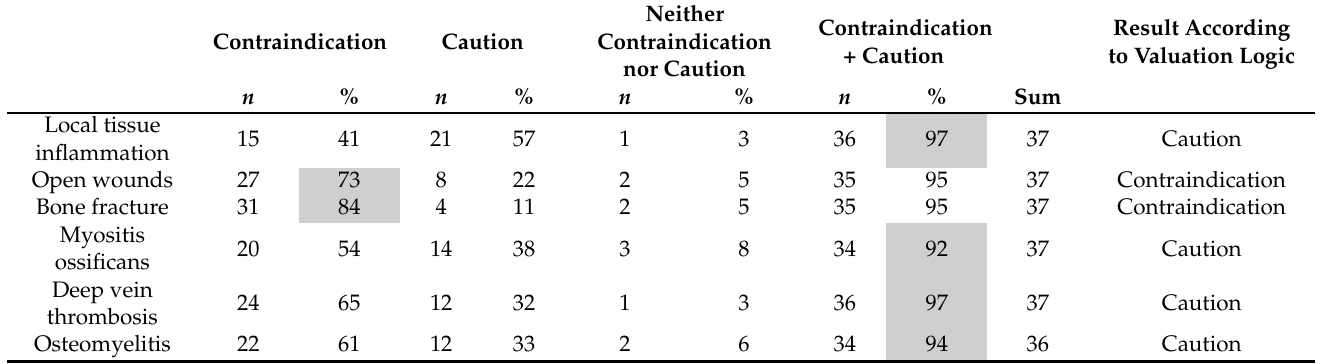
Table 3. Delphi process round 3 responses. Figures highlighted in grey met the a priori defined criteria for contraindica- tions/cautions.